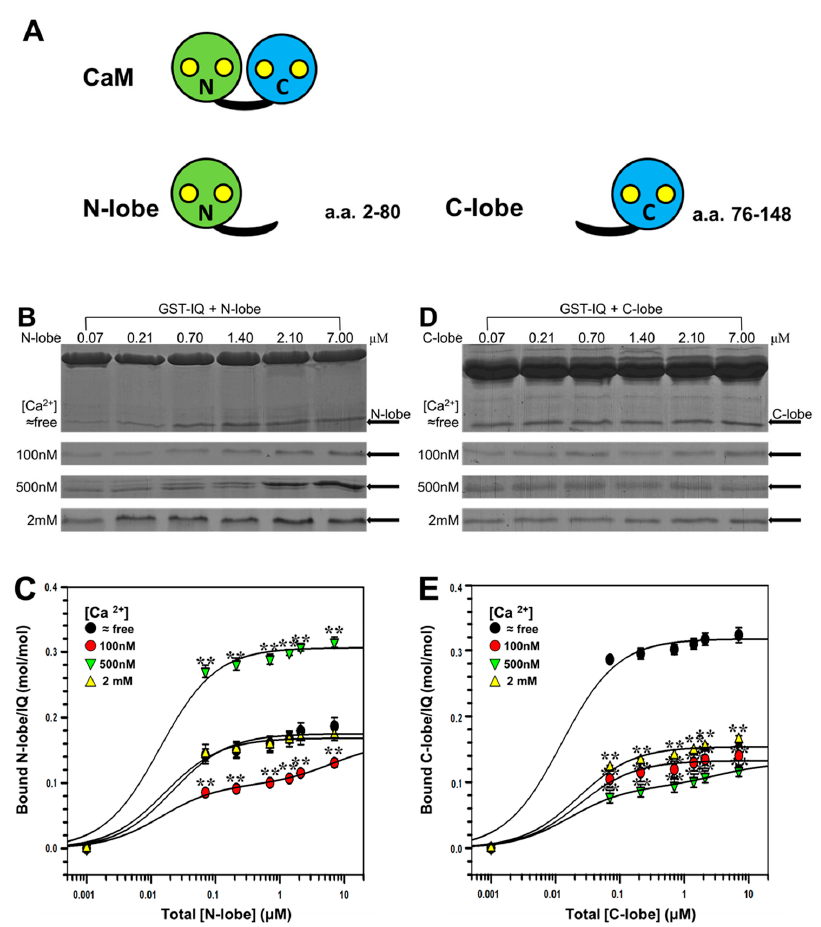
Figure 5. Interaction of the N-lobe/C-lobe of CaM with Na V 1.1 IQ domain by pull-down assay. ( A ) Schematic illustrations of CaM and its truncated protein N-lobe (green), C-lobe (blue). N-lobe peptide contains amino acids from 2 to 80 and C-lobe peptide contains amino acids from 76 to 148. Yellow circles represent normal Ca 2+ -binding sites on N/C-lobe; ( B , D ) GST pull-down assay for the binding of N-lobe ( B ) or C-lobe (D ) to IQ domain. GST-fusion IQ was incubated with increasing concentrations of N-lobe or C-lobe (0.07 to 7 μ m) at fixed [Ca 2+ ] of ≈ free, 100 nM, 500 nM, and 2 mM. Protein bands were stained by Coomassie Brilliant Blue. N-lobe or C-lobe bands are pointed out by arrows; and ( C , E ) Bound N-lobe ( C ) or C-lobe ( E ) are plotted against total [N-lobe] or [C-lobe] on a molar ratio basis (N-lobe or C-lobe/GST-IQ) with mean ± S.E. ( n = 4). ** p < 0.01, compared with corresponding bindings at Ca 2+ -free conditions.